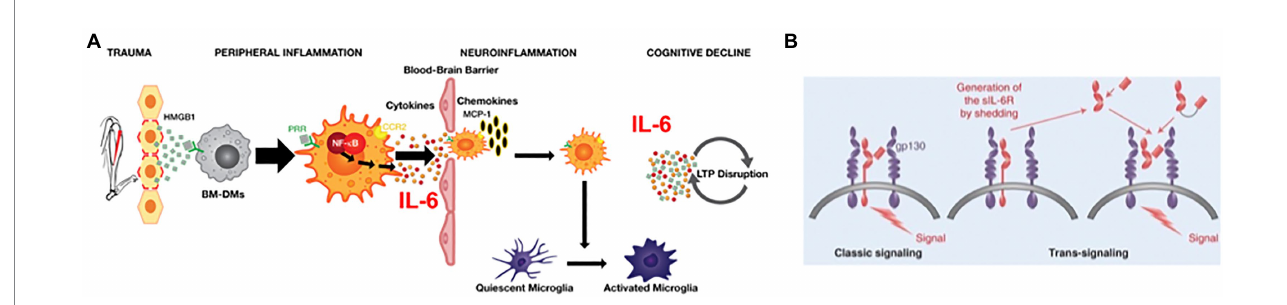
FIGURE 1 (A) Pathogenic model for Perioperative Neurocognitive Disorder in Mice. Peripheral trauma releases the alarmin HMGB1 which binds to pattern recognition receptors (PRRs) on circulating CCR2-expressing bone marrow-derived monocytes (BM-DMs) to transduce peripheral inflammation by translocating the transcription factor NF-kB into the nucleus and upregulating the synthesis and release of pro-inflammatory cytokines. High cytokine levels disrupt the blood brain barrier permitting entry of cytokines and BM-DMs into the hippocampus attracted by the chemokine MCP- 1. Resident microglia become activated and, together with BM-DMs, cause further release of cytokines (including IL-6) that signal through transduction pathways to disrupt long-term potentiation (LTP). (B) IL-6 signaling: In classic signaling circulating IL-6 binds to membrane-bound receptor, IL-6Ra, resulting in dimerization of the transduction component, gp130, which triggers intracellular signaling. In trans-signaling, the shed ectodomain of IL-6R, sIL-6R, binds to IL-6 and the resulting heteroduplex can trigger intracellular signaling by directly binding to the gp130 dimer in the absence of IL-6R. (Adapted from PMID: